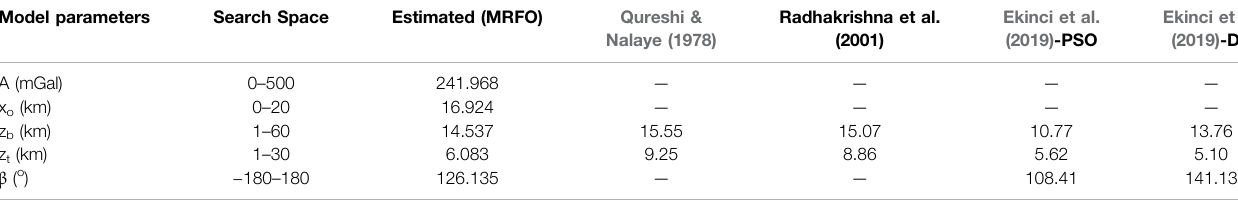
TABLE 8 | Comparative analysis of parameter results for Garber Oil Field Anomaly, United States Model parameters